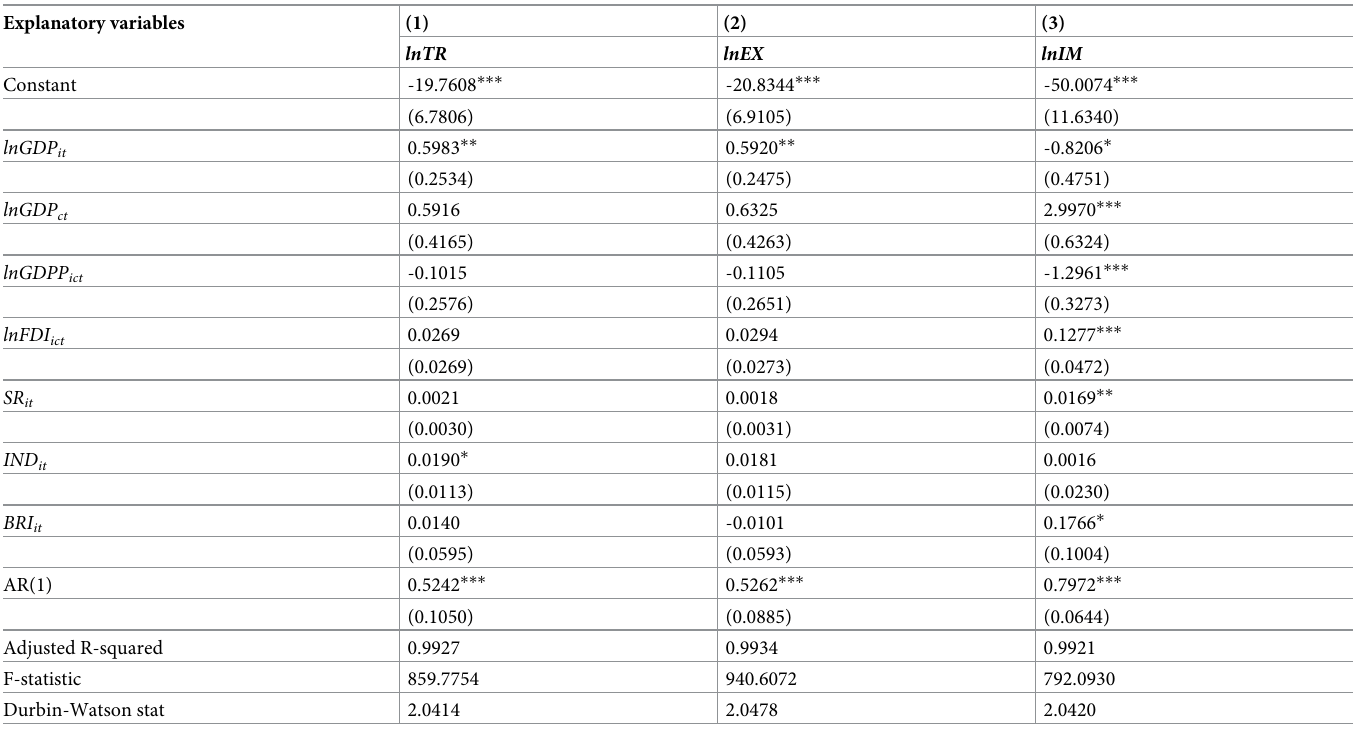
Table 7. Estimating results. Dependent variables: lnTR , lnEX and lnIM . Explanatory